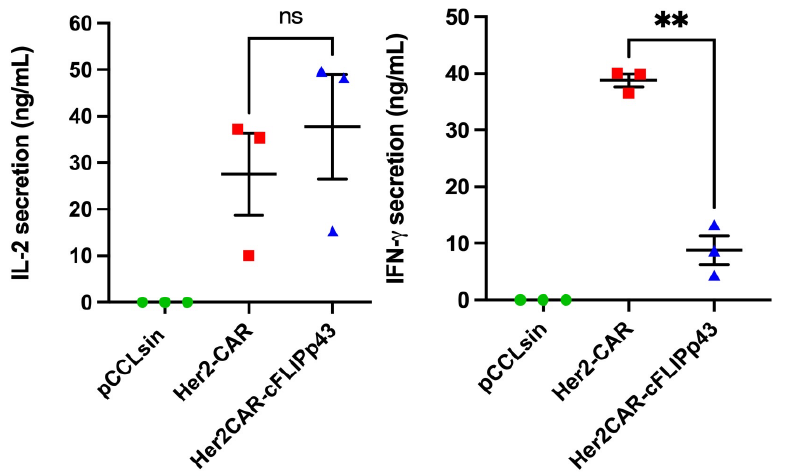
Figure 4. Her2CAR ‐ cFLIPp43 CAR T cells produce similar IL ‐ 2 levels as compared to control CAR T cells but exhibit reduced levels of IFN ‐γ upon Her ‐ 2 antigen stimulation. ( left ) Plots depicting in vitro cytokine concentrations of IL ‐ 2 and IFN ‐γ produced by transduced human primary T cells from three independent donors. At day 7 post ‐ transduction, negative control, pCCLsin ‐ , CAR ‐ con ‐ trol ‐ , Her2 ‐ CAR ‐ or Her2CAR ‐ cFLIPp43 ‐ transduced T cells were co ‐ incubated with Her2 + MCF ‐ 7 cell line (E: T, 2:1) for 24 h before supernatant was collected. The cytokine production in the super ‐ natant was detected by sandwich ELISA and was measured in ng/mL. Plots represent mean ± SEM from three independent donors. Statistical analysis was determined by two ‐ tailed paired t test, ns, non ‐ significant; ** p < 0.05. ( right ) Perforin and granzyme B production of CAR T cells groups meas ‐ ured by flow cytometry analysis. Negative control, pCCLsin ‐ , CAR ‐ control ‐ , Her2 ‐ CAR ‐ or Her2CAR ‐ cFLIPp43 ‐ transduced T cells were cocultured at a 2:1 ratio for six hours with Her2 ‐ target cells and four hours of Brefeldin A treatment. The cells were fixed and intracellularly stained with perforin and granzyme B antibody for flow cytometric analysis. Each experiment indicates different donor ( n = 3). Statistical analysis: two ‐ tailed paired t test.